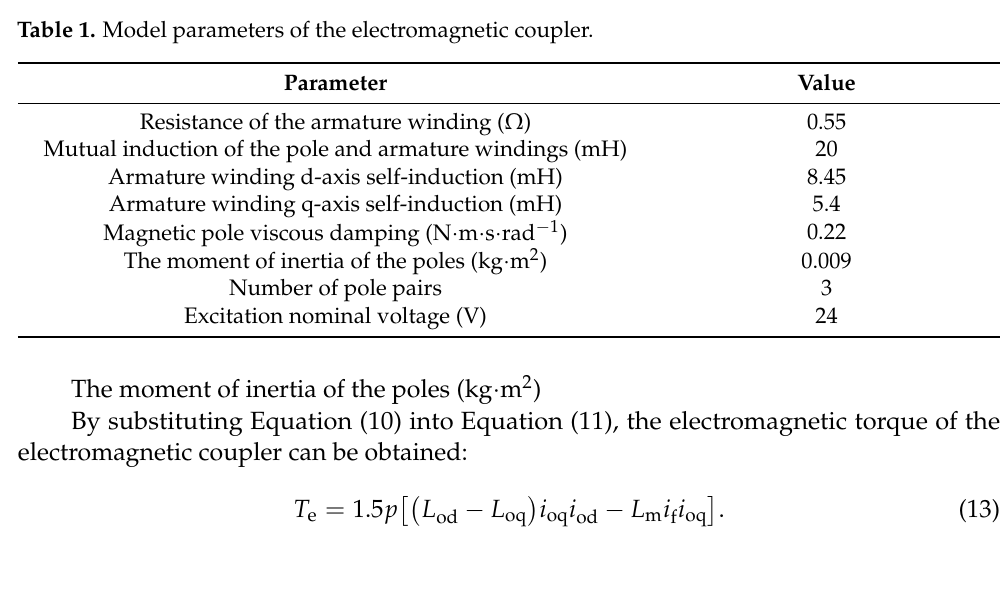
Table 1. Model parameters of the electromagnetic coupler. Parameter Value Resistance of the armature winding ( Ω ) 0.55 Mutual induction of the pole and armature windings (mH)